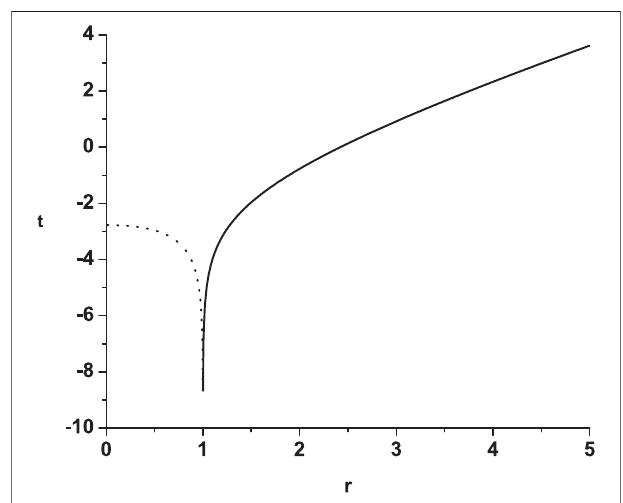
FIGURE5| Anoutgoingwavefromtheblackhole.Thecurverepresents U = C =const trajectory expressed in the Schwarzschild coordinates, with C = − 4. In the beginning, there are two components. The solid line goes from the horizon, r = 1, outward to in fi nity, r = ∞ , while the dotted line appears from the horizon and propagates to the singularity r = 0. At t = 2ln( − C ), the dotted line reaches the singularity. This is a generalization of the standard Hawking (pair creation) effect. This result implies that the outgoing particle is entangled with the black hole (and not its partner) after a very short time period, since its partner has already been absorbed at the